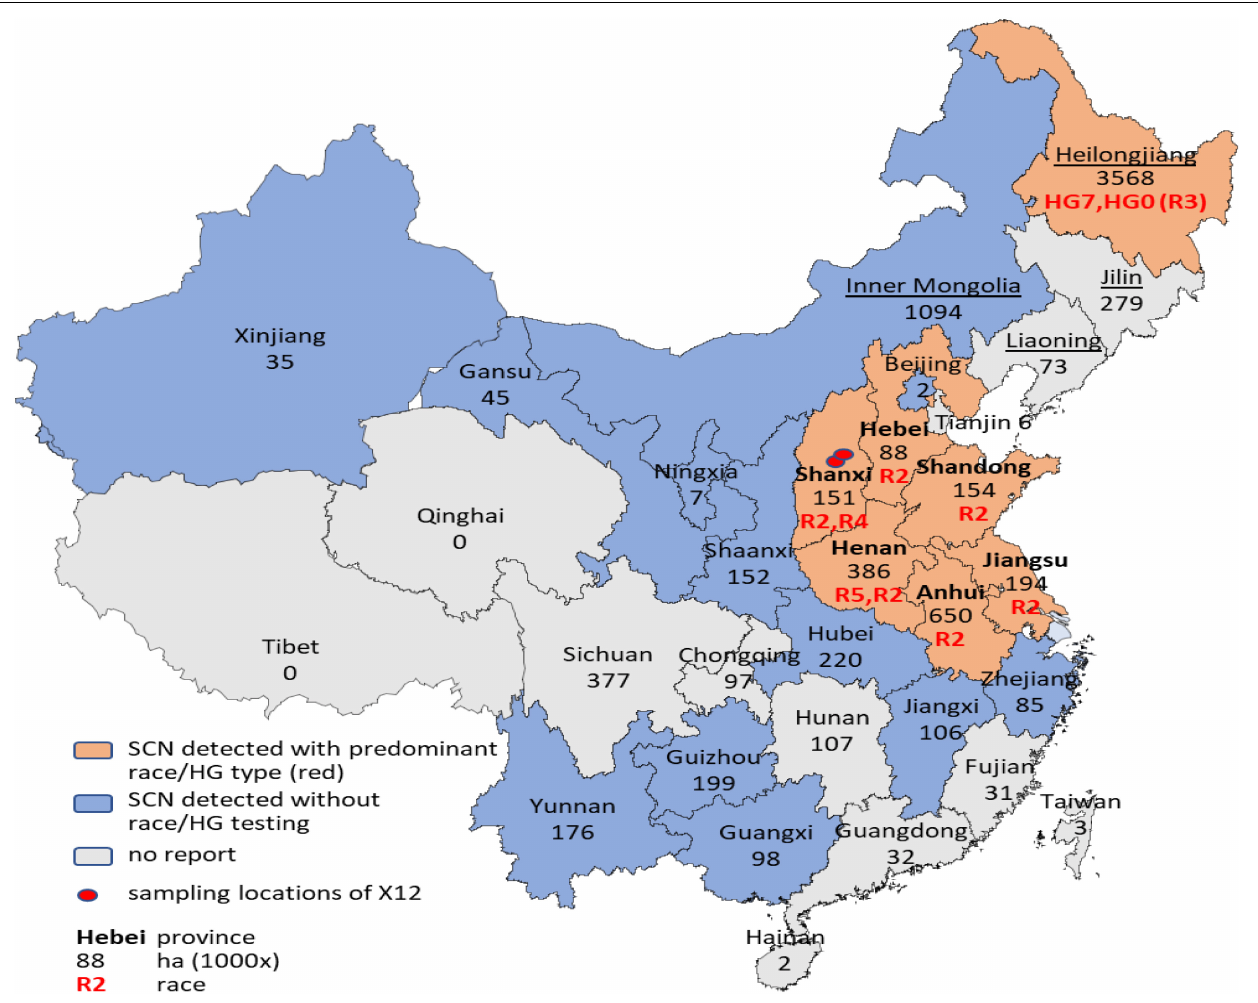
FIGURE 1 | The spatial distribution of soybean cyst nematodes (SCNs) in China. The names of the provinces of the main growing area of the Huang-Huai Valleys are typed in bold, and the names of the provinces of the Northeast growing area are underlined. Black numbers in the figure represent the soybean growing area in thousands of hectares (1,000 × ha) of 2018 (China Agriculture Yearbook). Red text indicates the predominant race(s) or HG